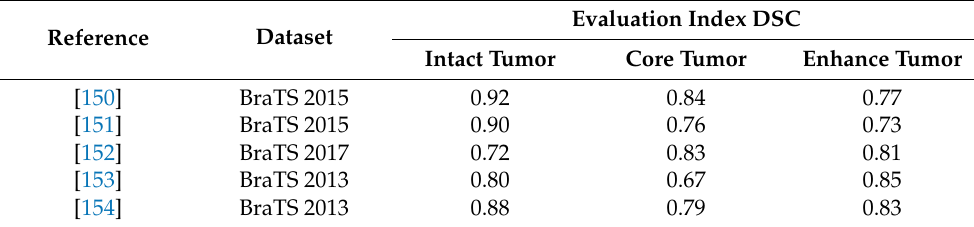
Table 5. Evaluation results of MRI brain tumor segmentation based on the multi-CNN